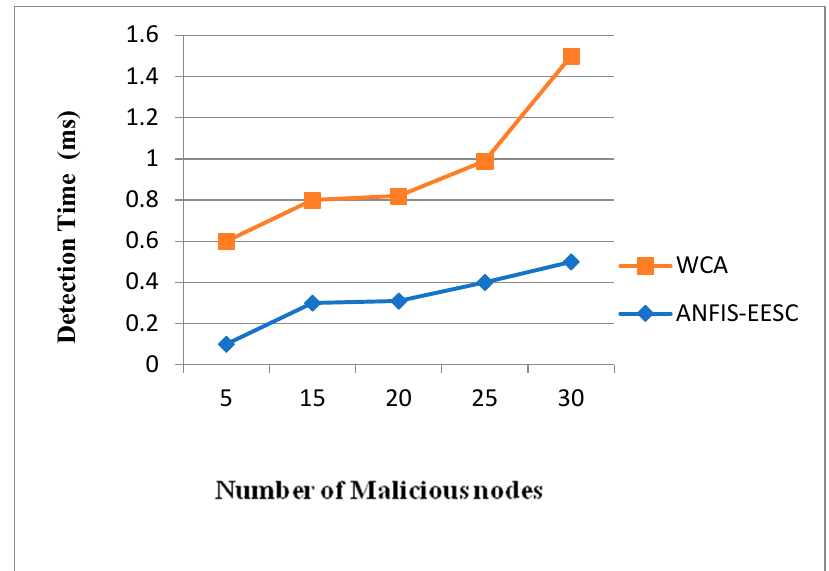
Figure 6. Detection time.